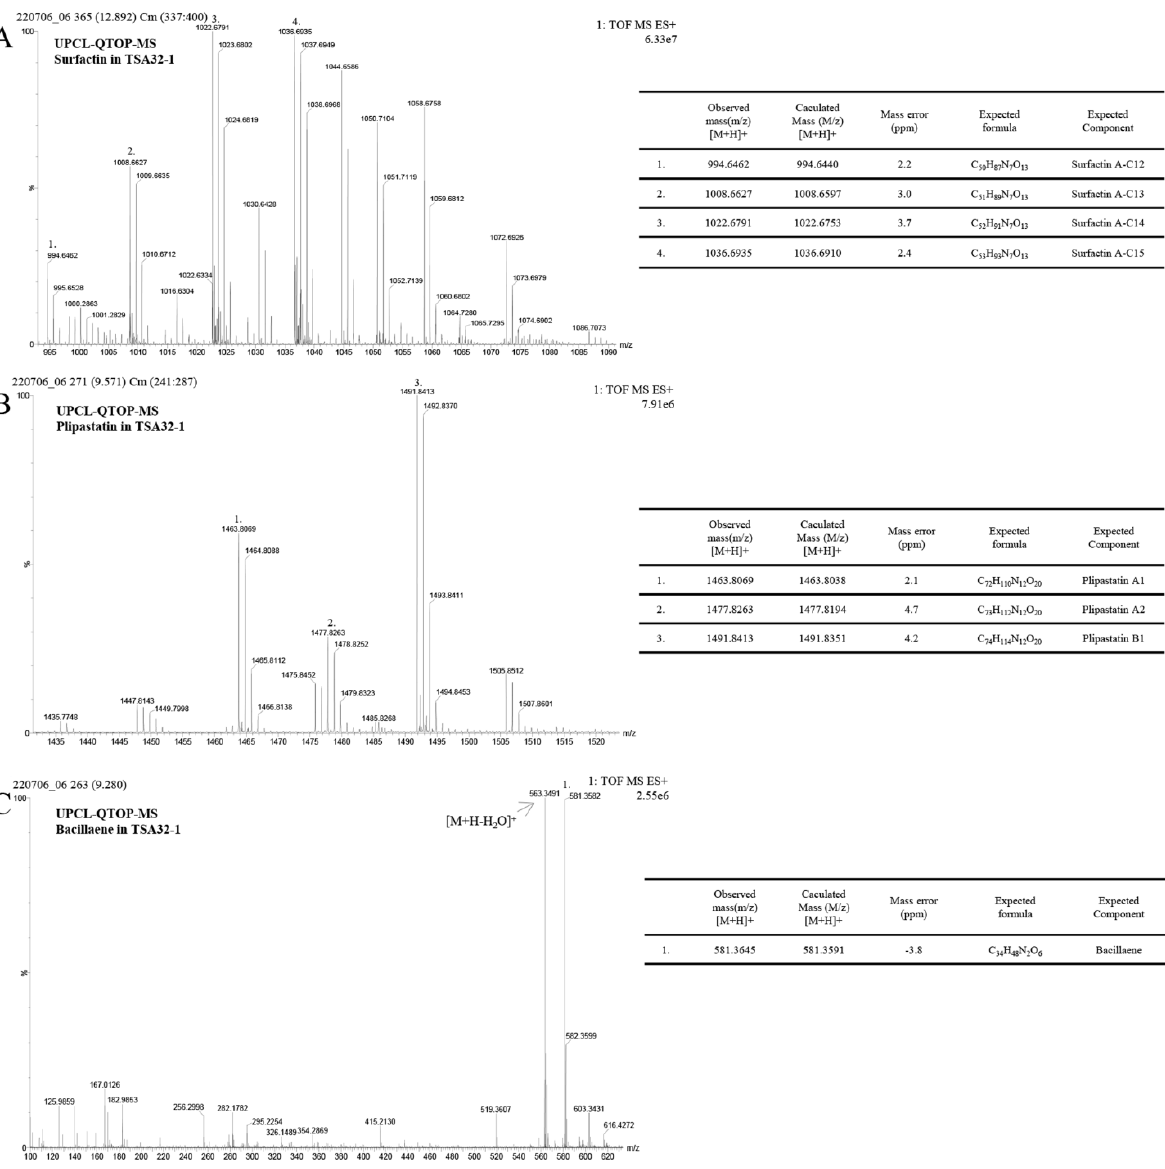
Figure 7. Identification of signaling metabolites in Bacillus velezensis TSA32-1. Extracts were fractioned using UPLC-QTOF-MS. ( A ) Mass spectrum of surfactin, ( B ) plipastatin, ( C ) bacillaene compounds in TSA32-1 culture extract.